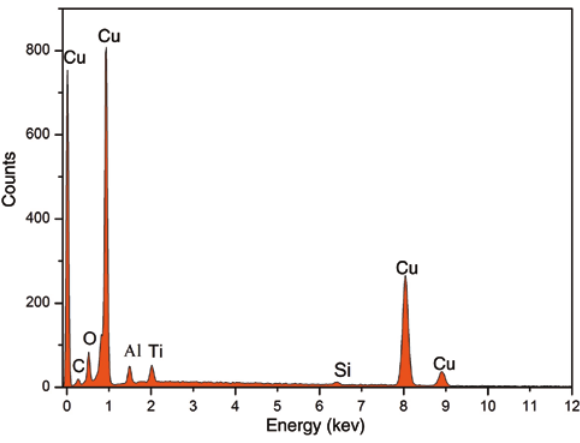
Figure 12: EDS mappings of the pantograph slide after wear